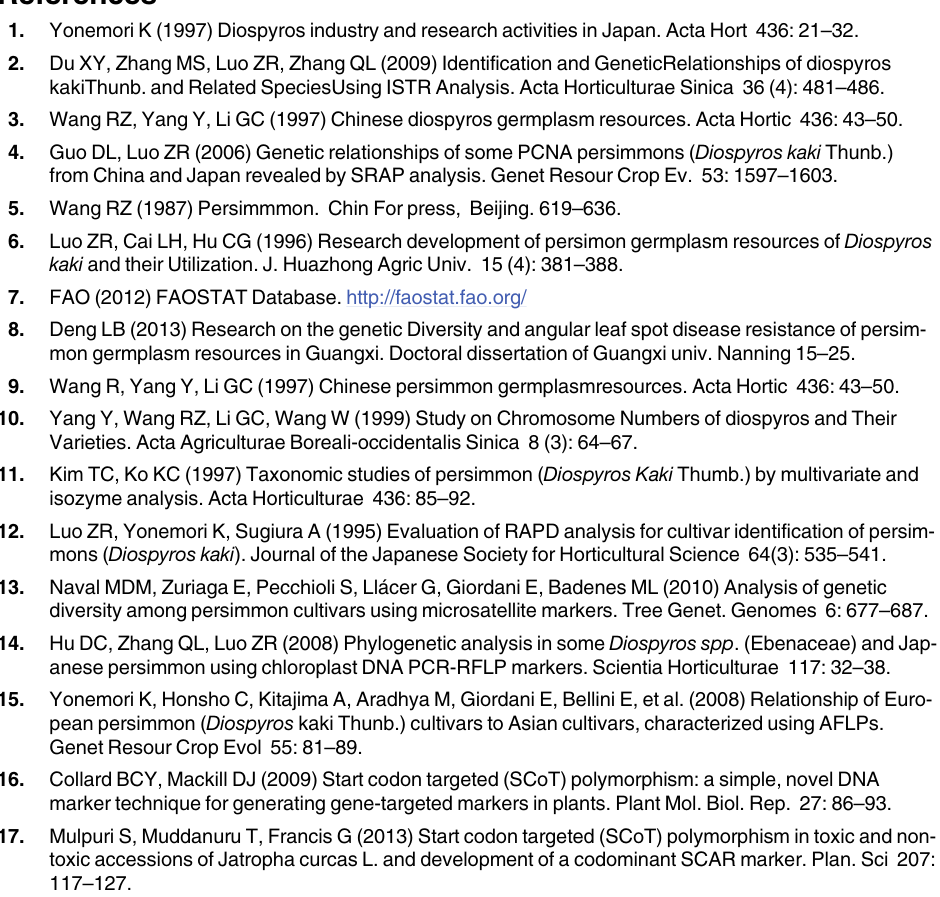
S1 Table. The surveyed populations and their respective ecological and geographical parameters.